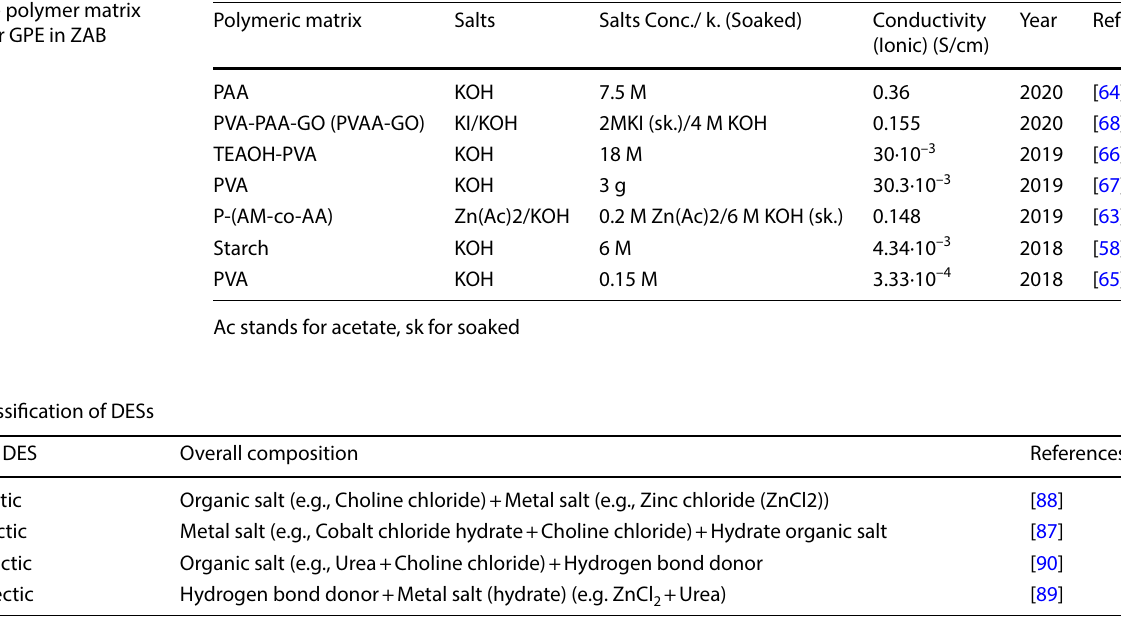
Table 6 The polymer matrix materials for GPE in ZAB